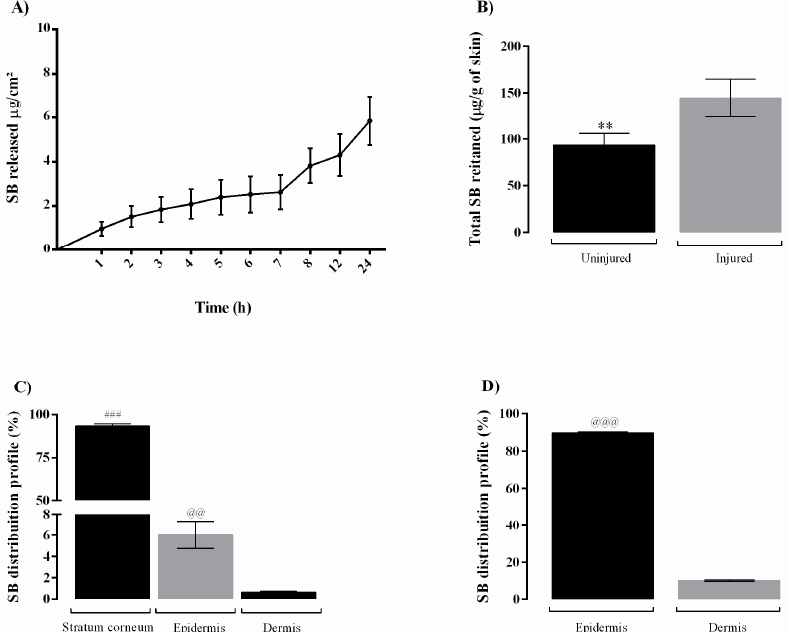
Figure 3. In vitro release profile and skin permeation of silibinin from nano-based bilayer film. ( A ) Cumulative amount of released silibinin from film in phosphate buffer receptor medium pH 7.4 at 32.0 °C ( n = 3); ( B ) Cumulative amount of retained silibinin in the uninjured and injured skin after 24 h of incubation ( n = 6); ( C ) Percentage of silibinin distribution in the different non-injured skin layers; ( D ) Percentage of silibinin distribution in the different injured skin layers. All the results are expressed as mean ± SEM. (**) p < 0.01 significant differences between cumulative amount of SB in the non-injured and injured skin, (###) p < 0.001 significant differences between SB quantified in the stratum corneum and epidermis in the non-injured skin, (@@) p < 0.01 and (@@@) p < 0.001 significant